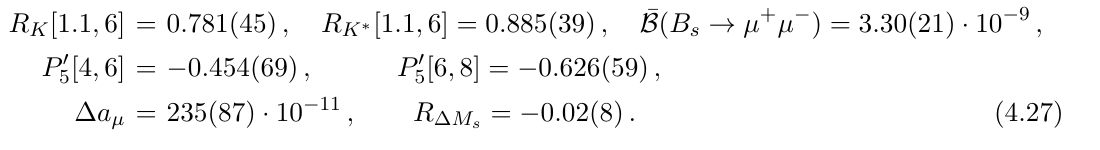
Figure 5 . Left panel: allowed region for the coupling strength to the muon j (cid:0) L anomalous magnetic moment as a function of j (cid:0) R 0 : 0015. The excluded region due to the requirement of perturbativity for j (cid:0) L;R Dark (light) green corresponds to 1 (cid:27) (2 (cid:27) ) region. The red star marks the benchmark point (1 : 5 ; 1 : 4). Right panel: same as the left panel, but assuming (cid:21) E =